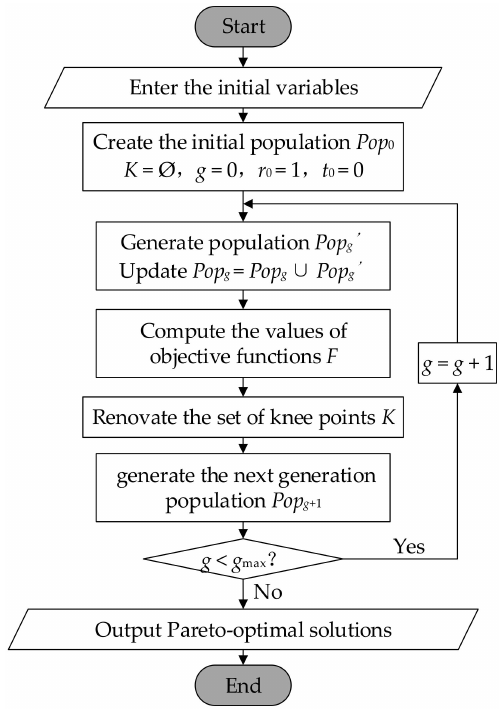
Figure 1. Process of optimization scheme by using knee point-driven evolutionary algorithm